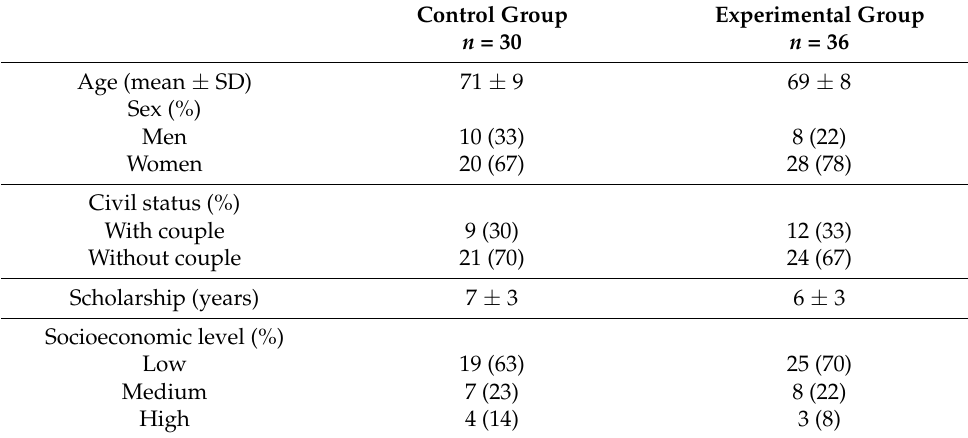
Table 2. Sociodemographic characteristics by study group.